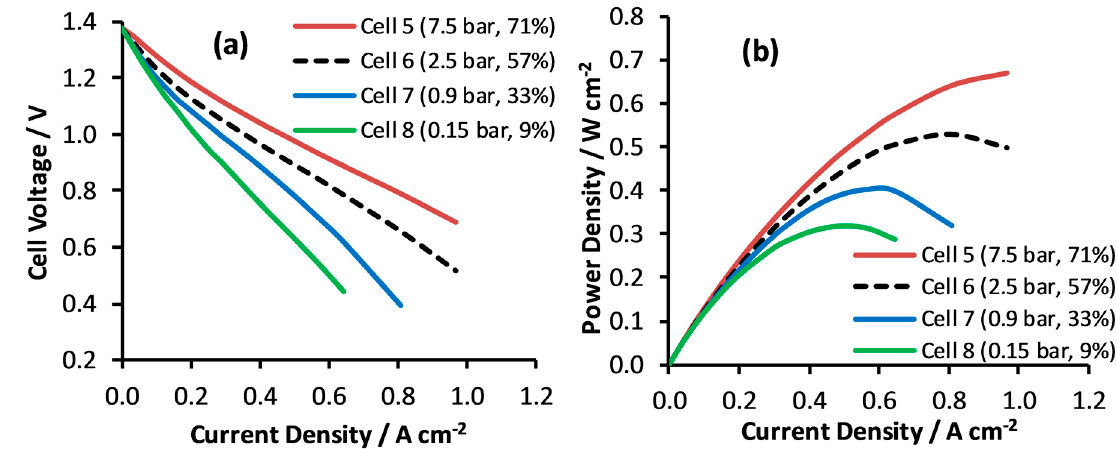
Figure 5. Plots of ( a ) cell operating voltage and ( b ) cell power density against current density for Cells 5–8 (labeled) with a range of active area compression pressures and % compression values.